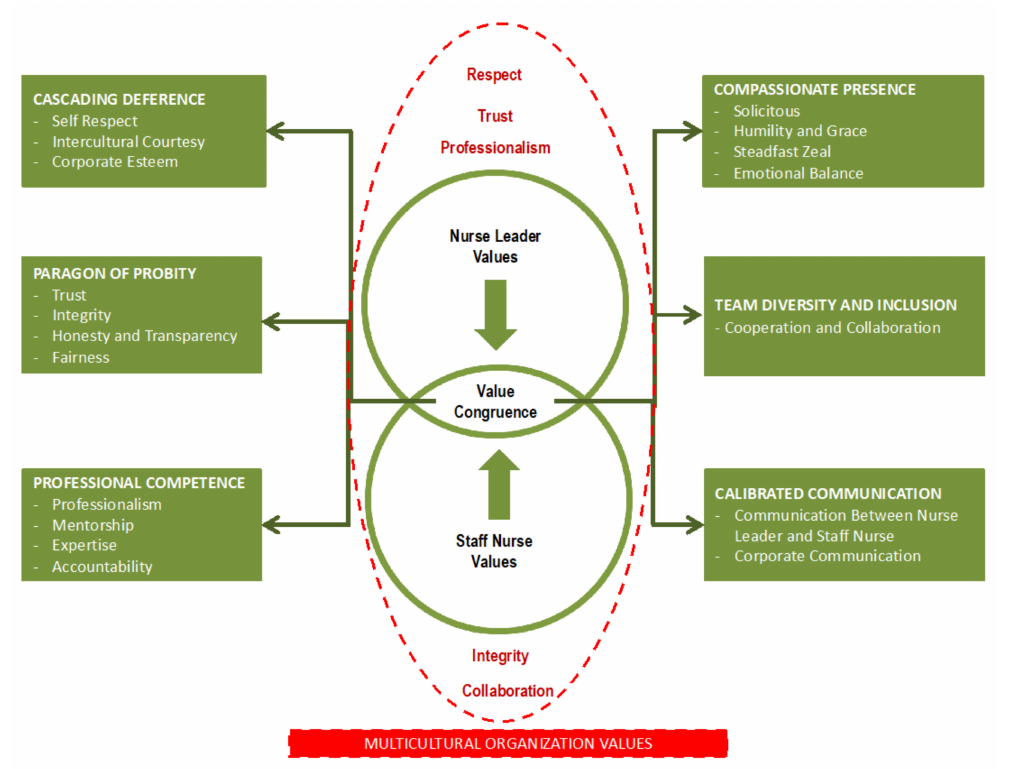
Figure 1. Themes and subthemes: congruent leadership values among the nurse leaders and staff